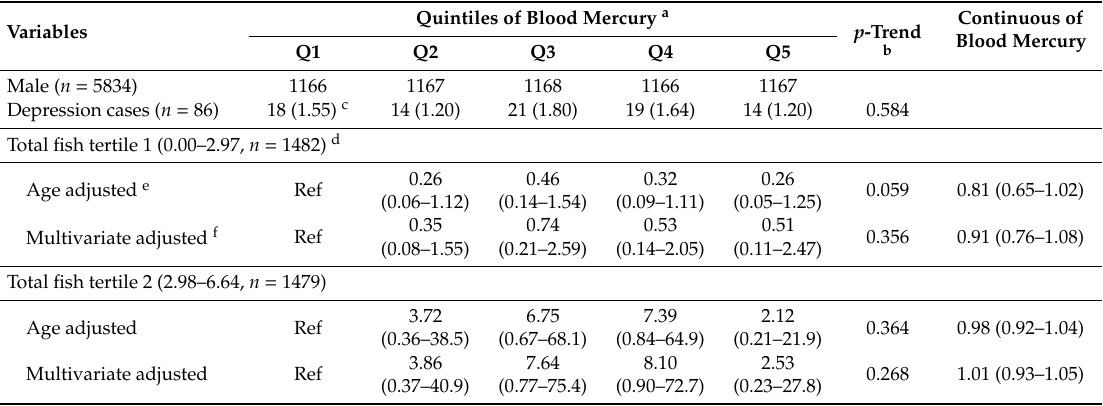
Table 3. Multivariate logistic regression for association between depression and blood mercury, by gender and fish intake (KNHANES